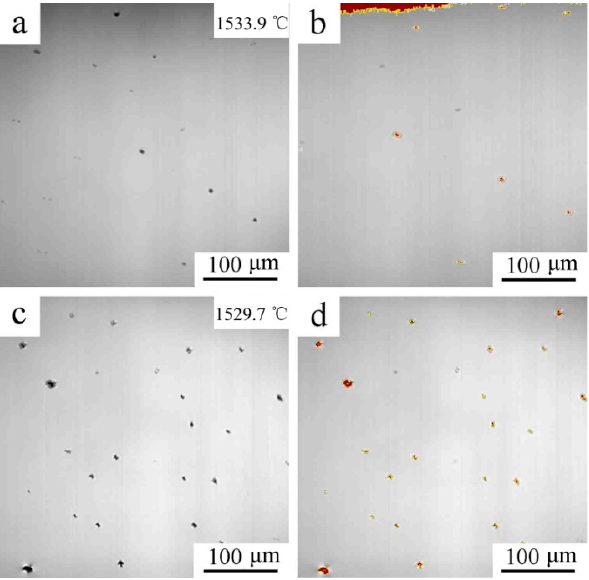
Figure 3. Extracted inclusions by image processing software ( a , b ) without PMF and ( c , d ) with PMF.